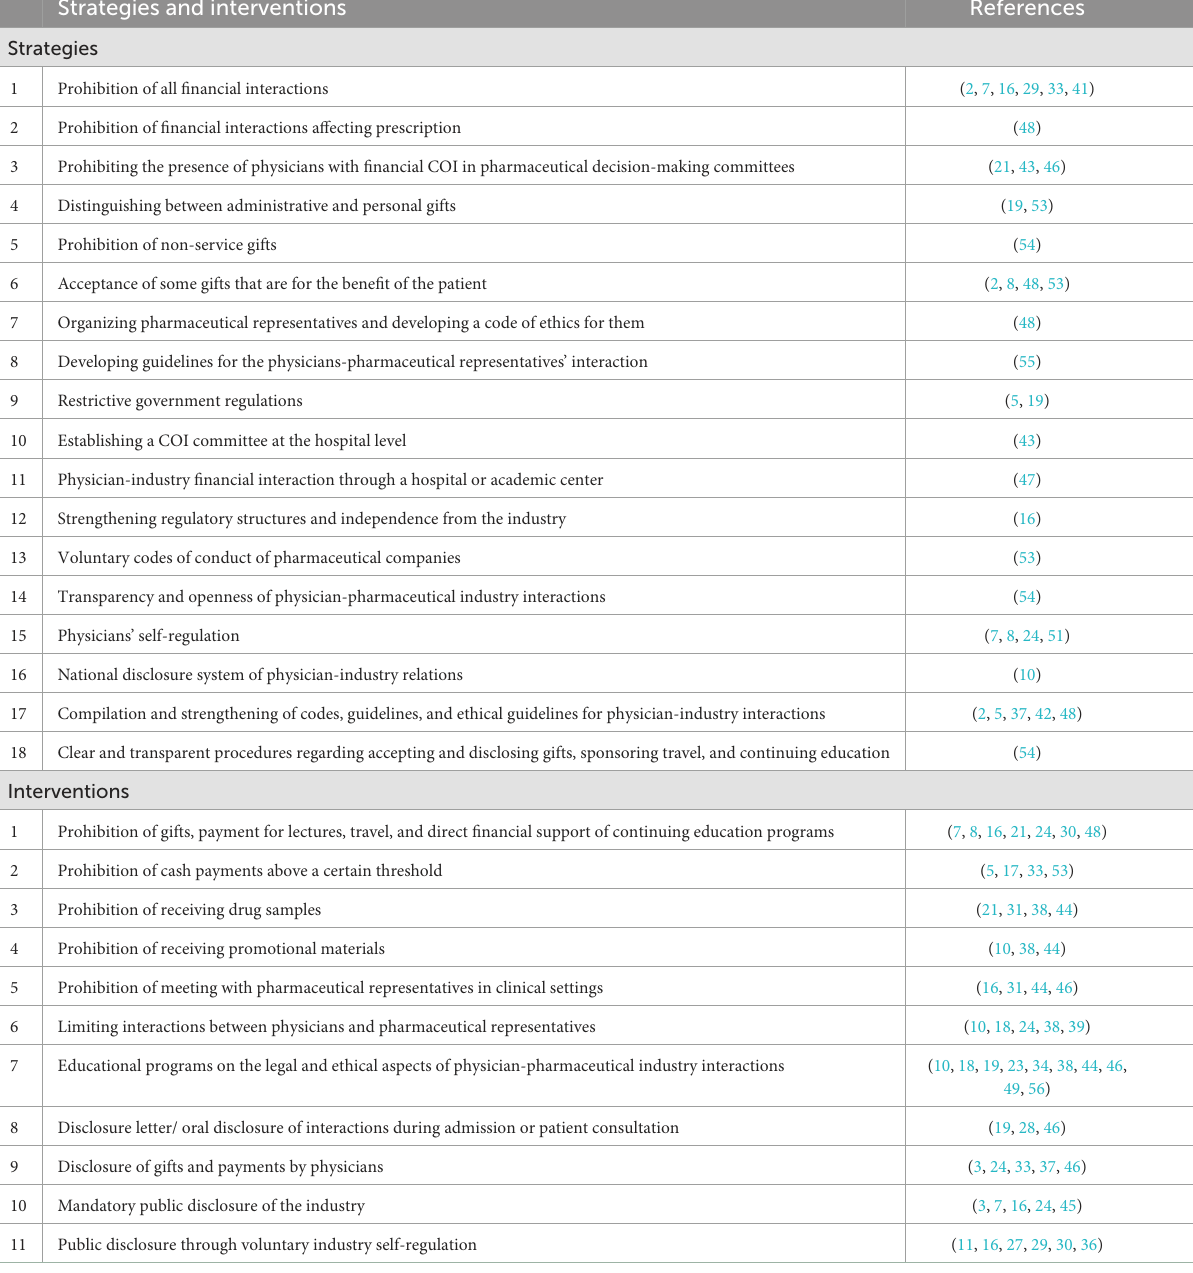
TABLE 2 Strategies and interventions extracted from the systematic review for managing COI of the physician-pharmaceutical industry. Strategies and